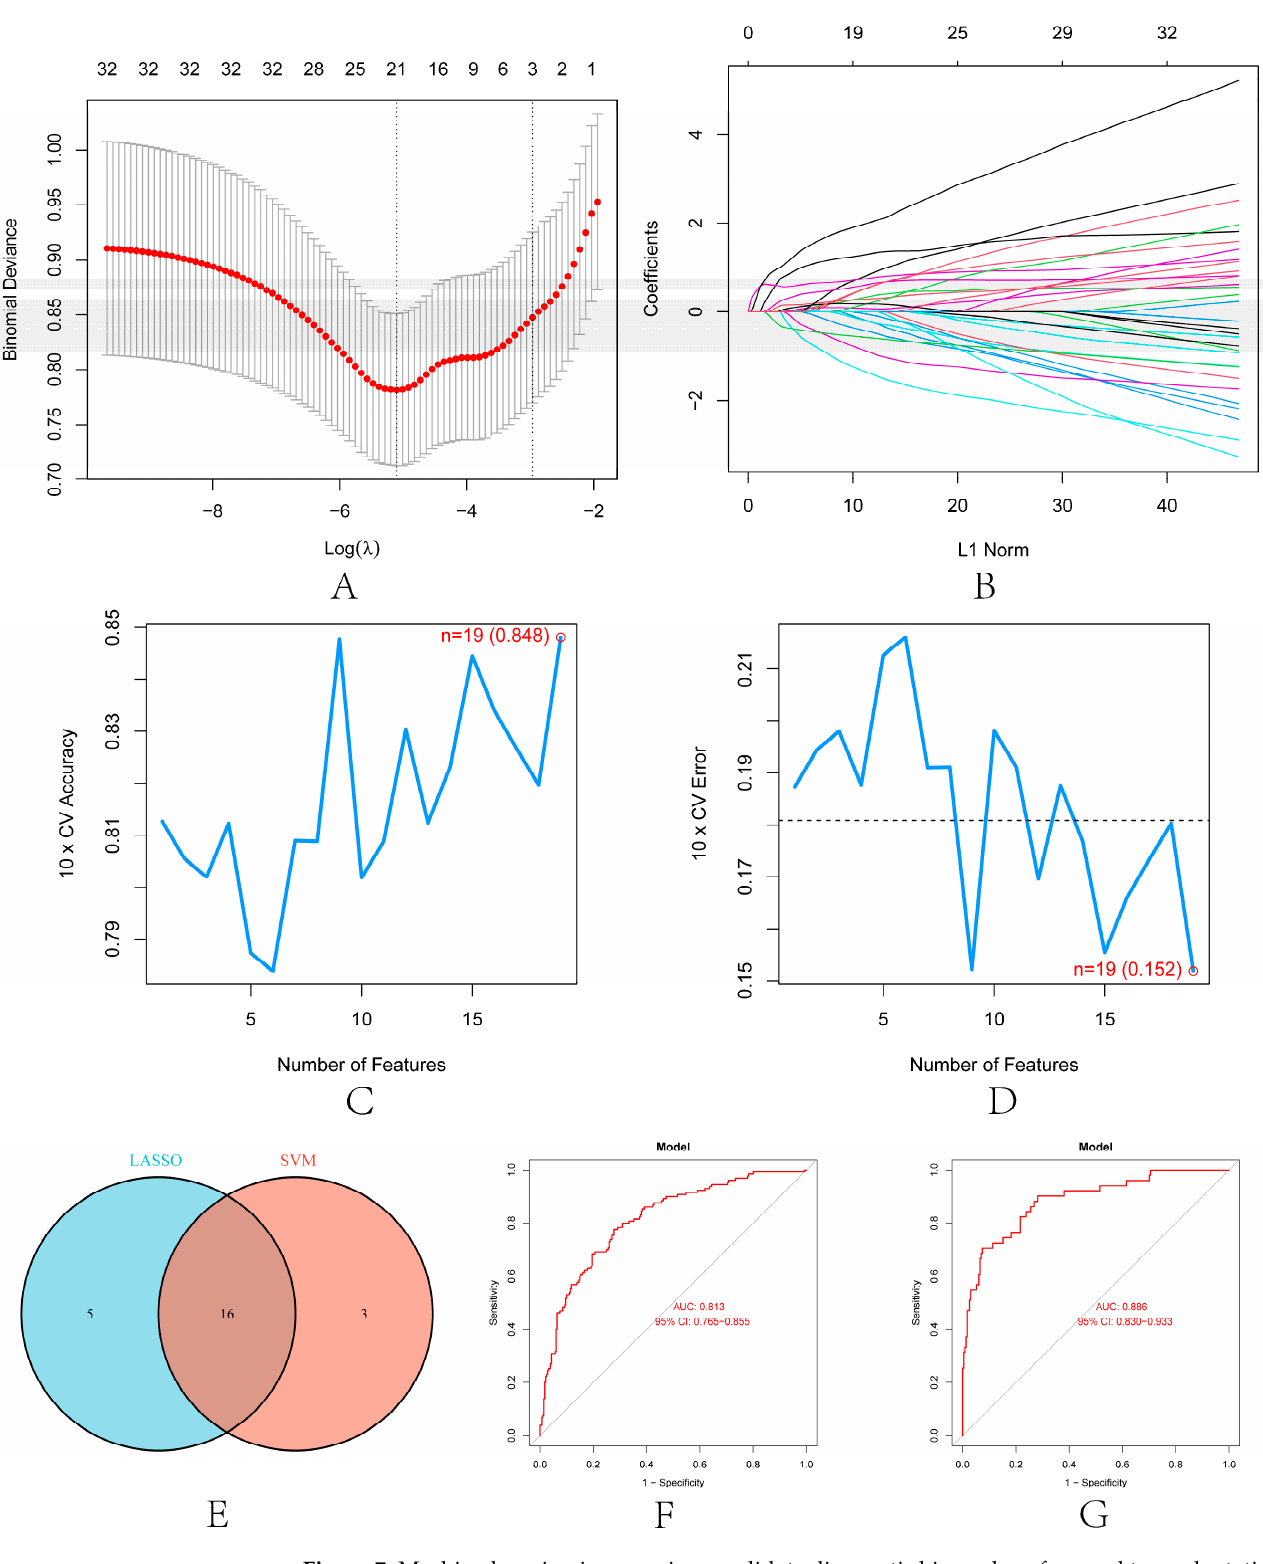
Figure 7. Machine learning in screening candidate diagnostic biomarkers for renal transplantation. ( A ) Plot of partial likelihood deviance. ( B ) Plot of LASSO coefficient profiles. Accuracy ( C ) and error ( D ) of 10-fold cross-validation (CV) in SVM-RFE algorithms, respectively. ( E ) Venn diagram showing the characteristic genes shared by LASSO and SVM-RFE algorithms. ROC curve evaluates the diagnostic performance of characteristic genes in GSE21374 ( F ) and GSE36059 ( G ).